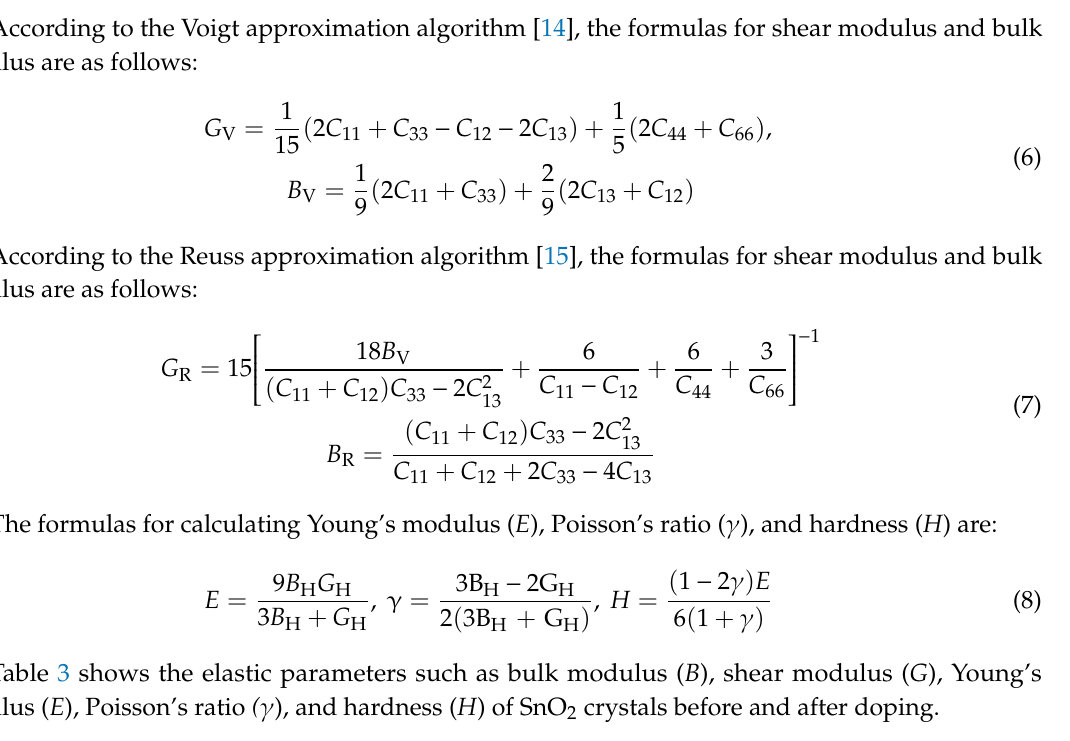
Table 3. Bulk modulus (GPa), shear modulus (GPa), Young’s modulus (GPa), poisson’s ratio γ ,